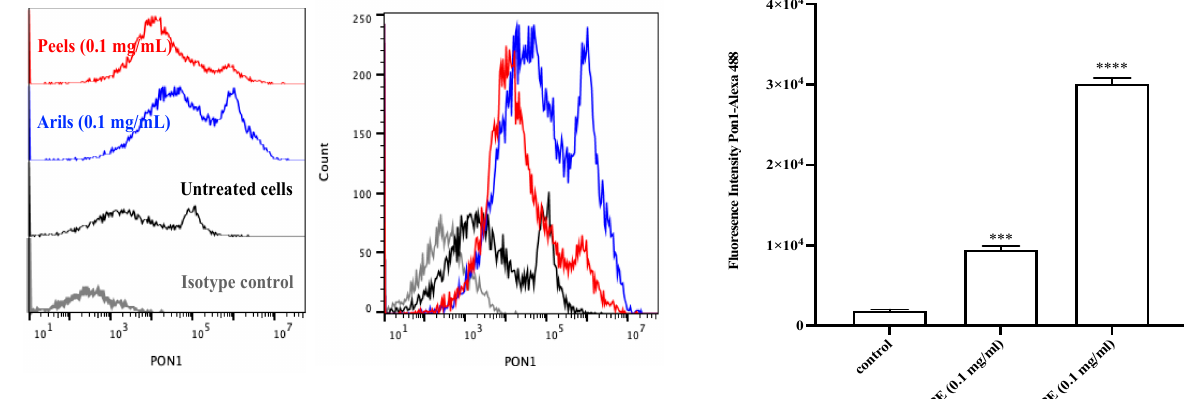
Figure 4. The extract of pomegranate peel and aril induces PON1 expression in Fu5AH cells. Fu5AH cells were cultured for 4 h in the presence (100 ug/mL) or absence of the extract of pomegranate’s peel or aril. The cells were washed and labelled with anti-PON1 mAbs. Expression of PON1 was determined by multi-color flow cytometry analysis in cells exposed or not to peels or arils extracts. Mean fluorescence intensities (MFI) values of FACS profiles are shown. Data are representative of three independent experiments. The asterisks indicate statistically significant differences determined by one-way ANOVA tests. *** p < 0.001 and **** p <